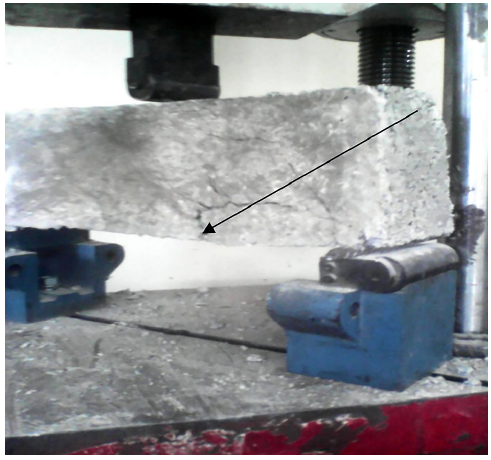
Fig. 9. Bending moment cracks in beam with